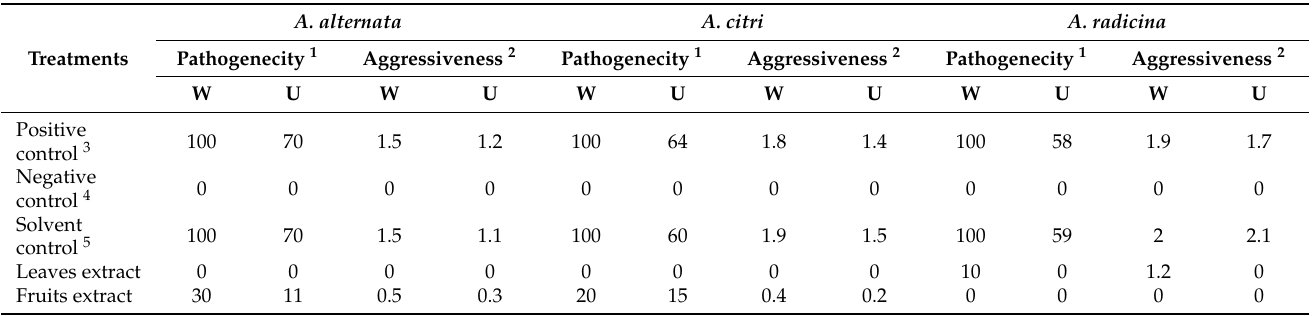
Table 5. Effect of Z. spina-christi L.leaves and fruits extracts on pathogenicity and aggressiveness of Alternaria alternata , A. citri , and A.radicina on tomato